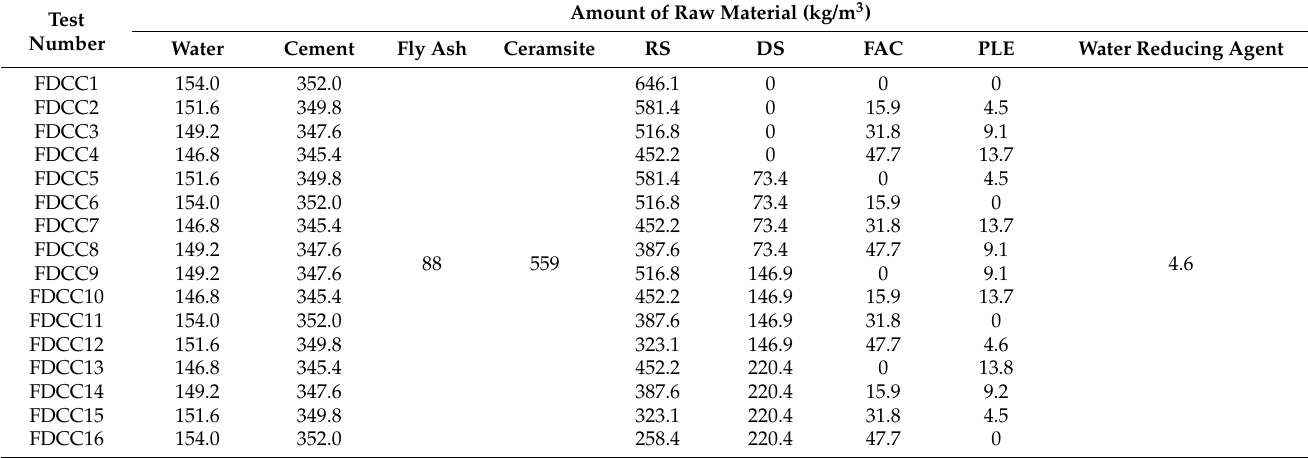
Table 6. The dosage of each